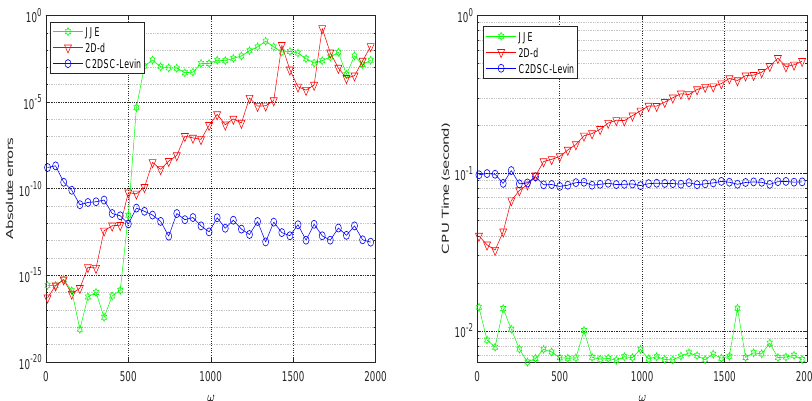
Figure 7. Comparison of JJE, 2D-d and C2DSC-Levin in Example 3, ω is a variable (left: absolute errors, right: CPU time).